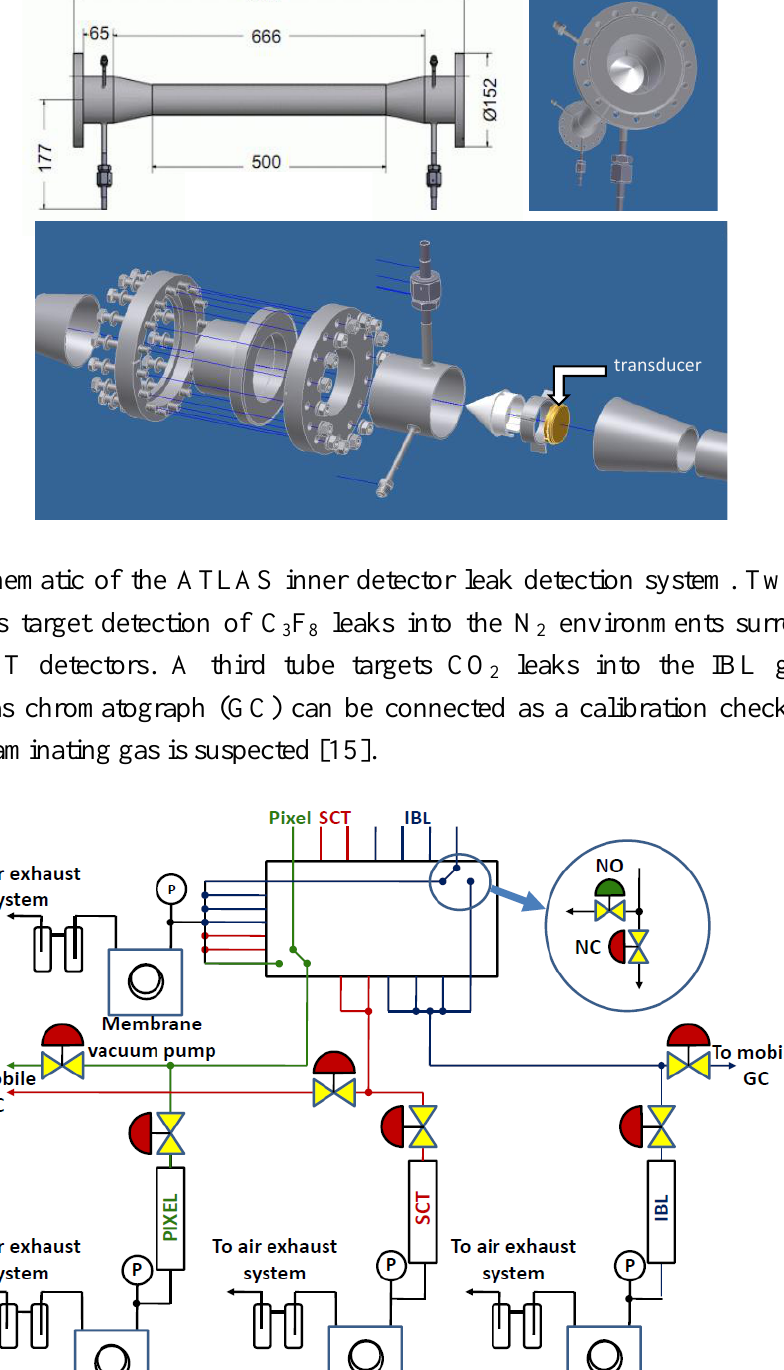
Figure 4. The schematics show the implementation of a stainless steel analyzer tube, with the transducer highlighted in gold in bottom detail. The central tube inner diameter is pinched to be the same as the ultrasonic transducers. This version allows volume flow measurement to ~230 L min −1 , in addition to the measuring the gas mixture ratio.